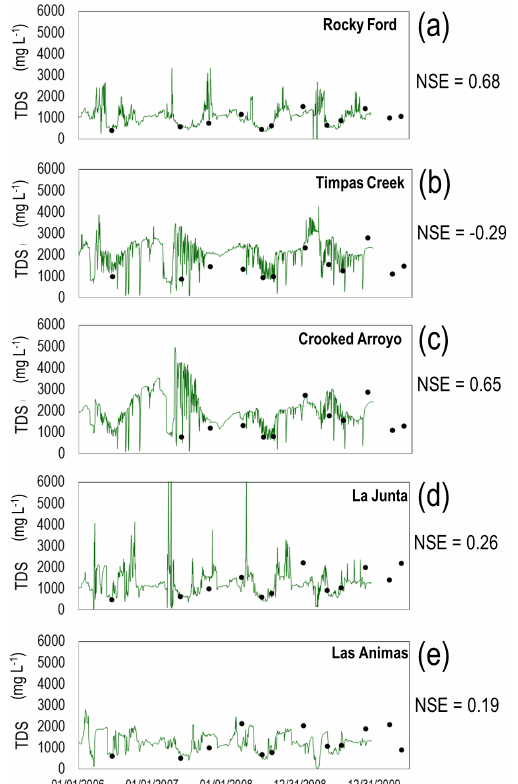
Figure 6. Simulated and observed total dissolved solids (TDS) (mgL − 1 ) in the five stream sampling sites along the Arkansas River (a, d, e) and two tributaries (b, c) . See Fig. 3 for locations. TDS is the summation of the concentration of the eight salt ions. The Nash– Sutcliffe model efficiency coefficient (NSE) is shown for each